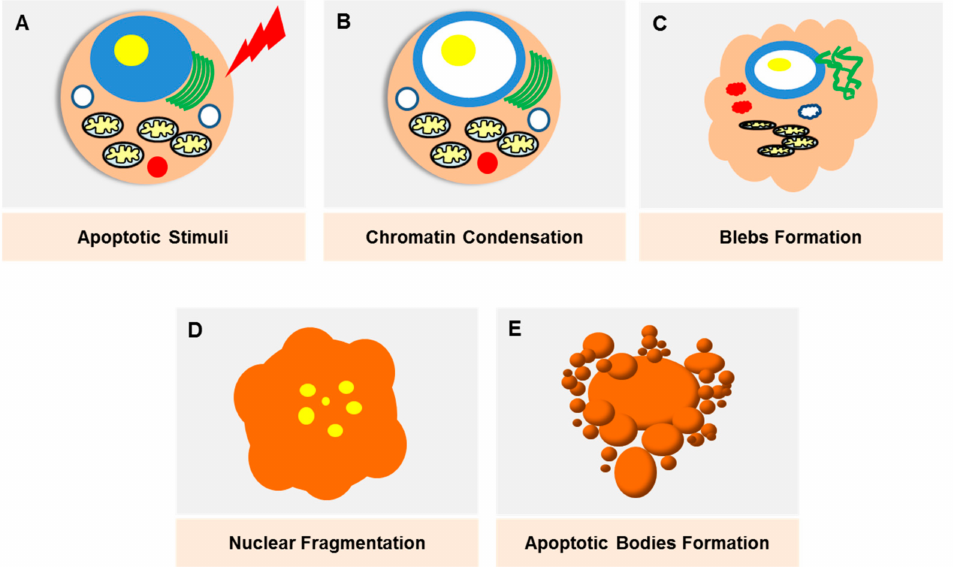
Figure 2. Damaged cells, stress stimuli or other triggering signals will initiate the apoptotic path- way. ( A ) The onset of apoptosis is characterised by chromatin condensation ( B ) as well as nuclear condensation. The loss of microvilli creates protrusions of the plasma membrane (blebs) ( C ). Nu- clear condensation starts peripherally and finally results in fragmentation, which is also known as karyorrhexis ( D ). As the cell shrinks, the blebs separate, forming apoptotic bodies which are densely packed with cellular organelles and DNA fragments ( E ). These bodies will be rapidly phagoscytosed into macrophages and parenchymal cells without triggering an inflammatory